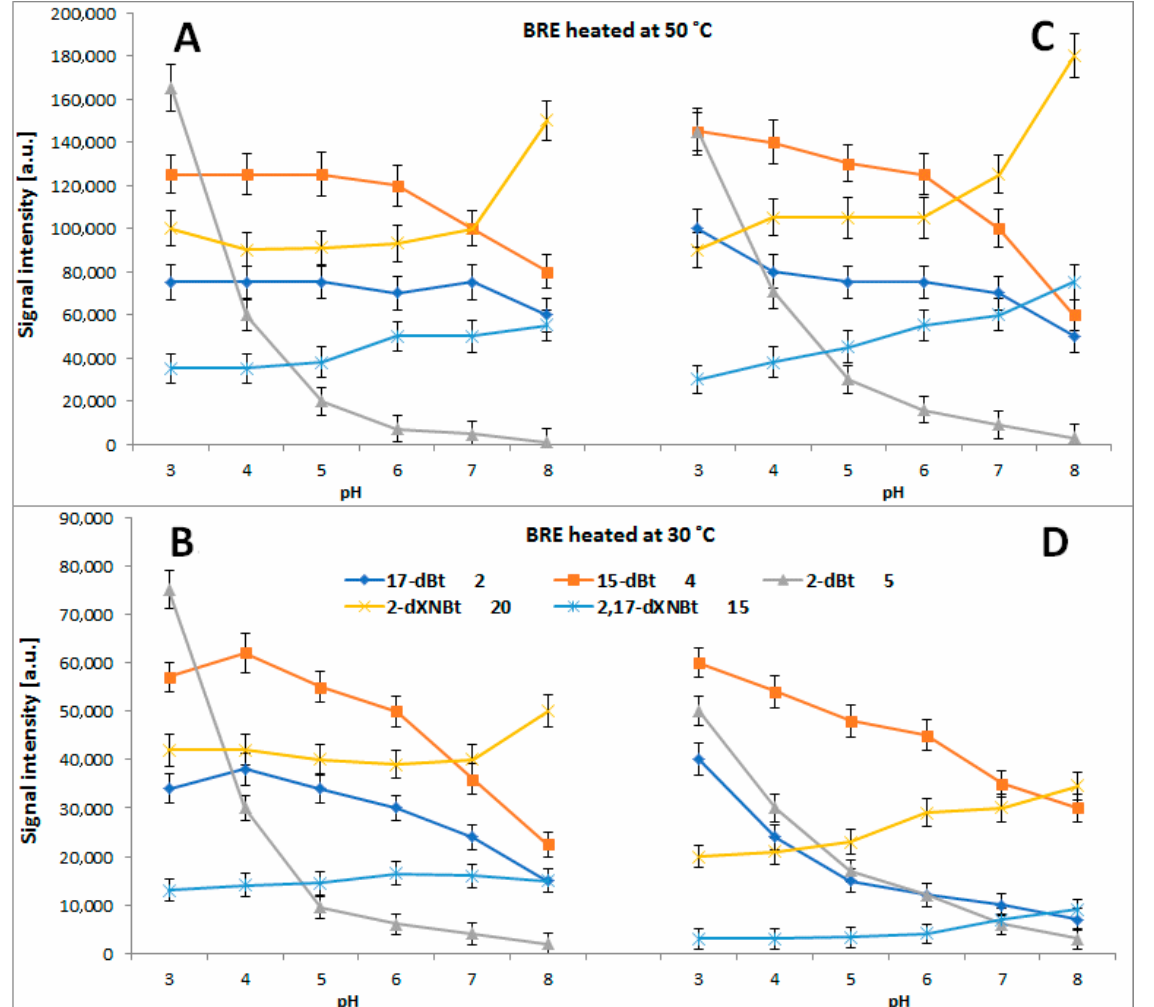
Figure 12. LC-MS signal levels of prominent mono-decarboxylated betanin derivatives ( 2 , 4 and 5 ) and most hydrophobic xanneobetanins ( 15 and 20 ) detected after 5 h ( A , C ) and 3 days ( B , D ) extract heating at 50 and 30 °C, respectively, in acetate/phosphate ( A , B ) and citrate ( C , D ) buffer solutions in dependence on pH.